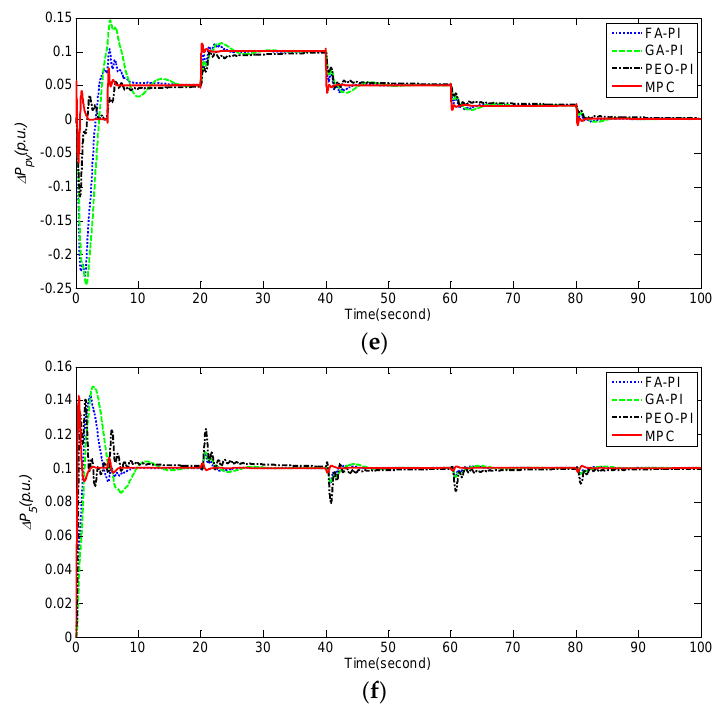
Figure 10. Comparison of frequency deviations ∆ f 1 , ∆ f 2 , and power deviations ∆ P tie , ∆ P pv , ∆ P 5 obtained by different control methods under dynamical fluctuations of ∆ P L 1 for case 5. ( a ) ∆ P L 1 ;